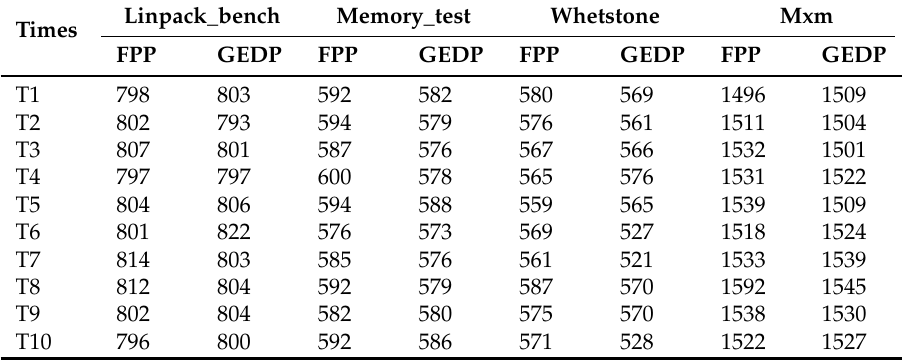
Table 3. The ten experiments’ data. FPP, fixed-priority tasks with preemption scheduling; GEDP, group-based energy-efficient dual priority scheduling.